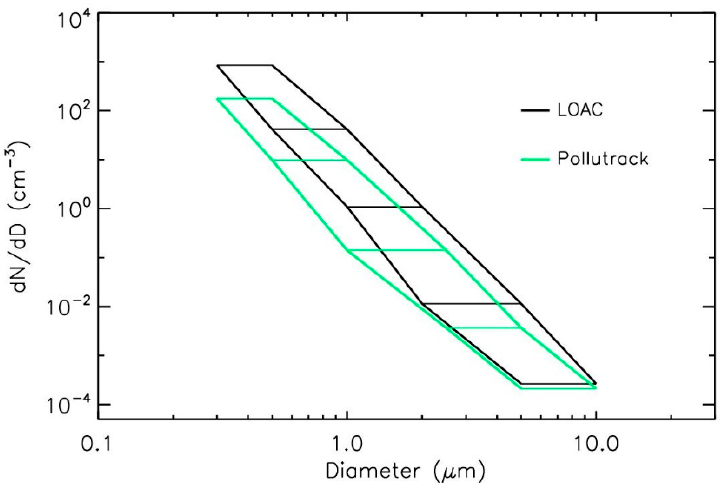
Figure 3. Mean size distribution for the Pollutrack and LOAC sensors at the “Ballon de Paris Gen-